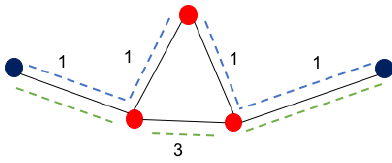
Figure 5. An example of a red–blue edge-weighted graph. The optimal solution (top blue) uses four edges, which leads to an overall edge cost of 4; terminal connectivity is achievable with just three edges (bottom green), but with a higher edge cost of